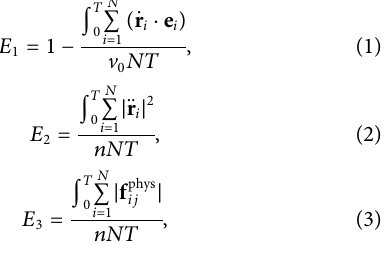
FIGURE 2 Schematicofthepreviousmodel(Kanoetal.,2021). (A) Based on the present position and velocity of the cars (blue fi lled circles and arrows, respectively), their future trajectories are estimated by numerically solving adifferential equation [Step (ii)](blue, red, and green dashed circles). (B) Schematic of the time evolution of the distance between cars i and j for the situation shown in (A)